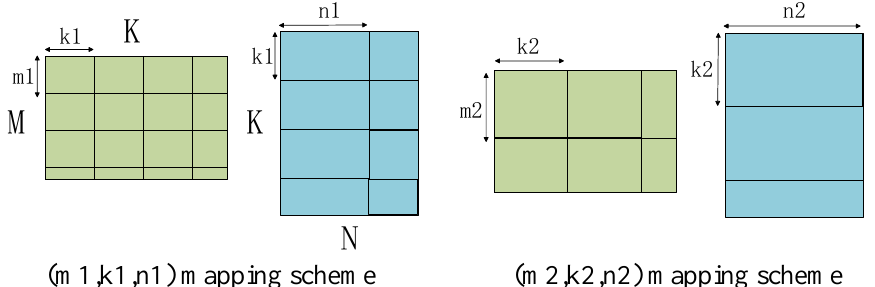
Figure 9. Examples of different mapping schemes.